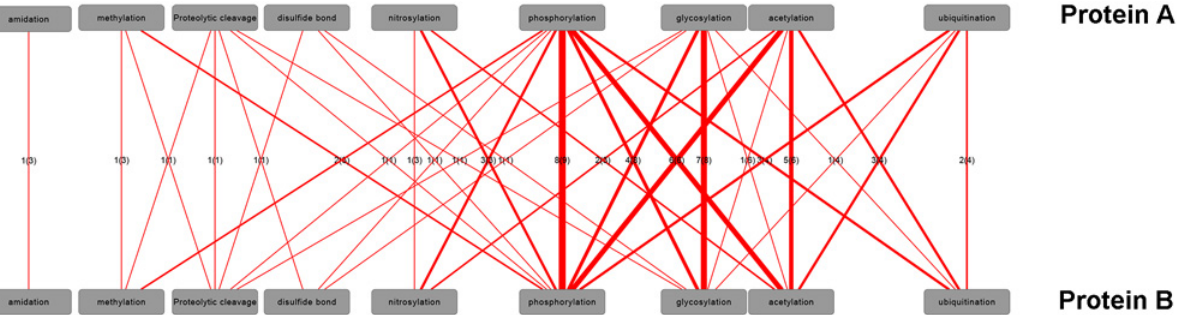
Figure 6. Pairwise interactions of proteins carrying different PTM-types (one-PTM-type-only dataset, see Methods). Number of species with statistically increased frequency of protein-protein interactions (designated as protein A and B, respectively) carrying the respective PTM-types. Linewidth is set proportional to the number of species (indicated as edge labels), which exhibit significant interactions of PTM-types carried by interacting proteins. The value in the parentheses corresponds to the number of common species with available PTM and PIN information. The contingency table for the Fisher exact test contained the respective counts for number of proteins associated with a particular PTM-pair versus all alternative pairings and whether they have been reported to interact or not with FDR-corrected p-value < 0.01. Note that the counts of pairwise interactions between protein A and B are by definition symmetric. Hence, labels were added to one direction only. Sumoylation, hydroxylation, and carboxylation were left out because no related significant interactions were found.